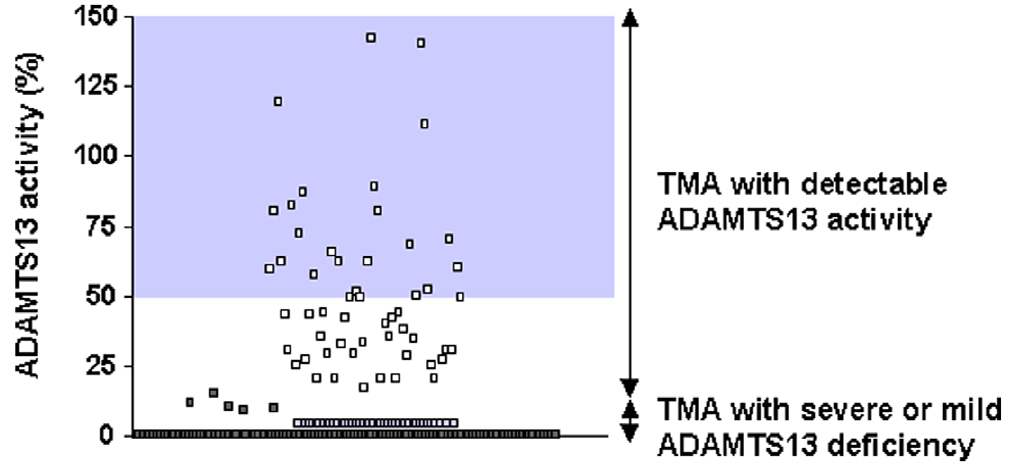
Figure 2. ADAMTS13 value on diagnosis. Dark grey squares: deficient ADAMTS13 activity with inhibitory or non-inhibitory anti-ADAMTS13 antibodies; light grey squares: deficient ADAMTS13 activity with suspected inhibitory or non-inhibitory anti-ADAMTS13 antibodies; white squares: detectable ( $ 20%) ADAMTS13 activity. Grey area delimits ADAMTS13 values of normal subjects. Abbreviation: TMA, thrombotic microangiopathy.